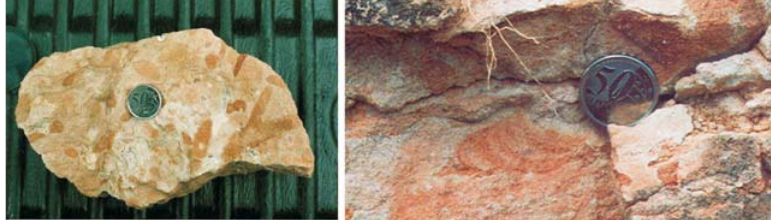
Figura 7. Bioturbação gerada por invertebrados em horizonte glei (Formação Marília, Cretáceo, Duartina,